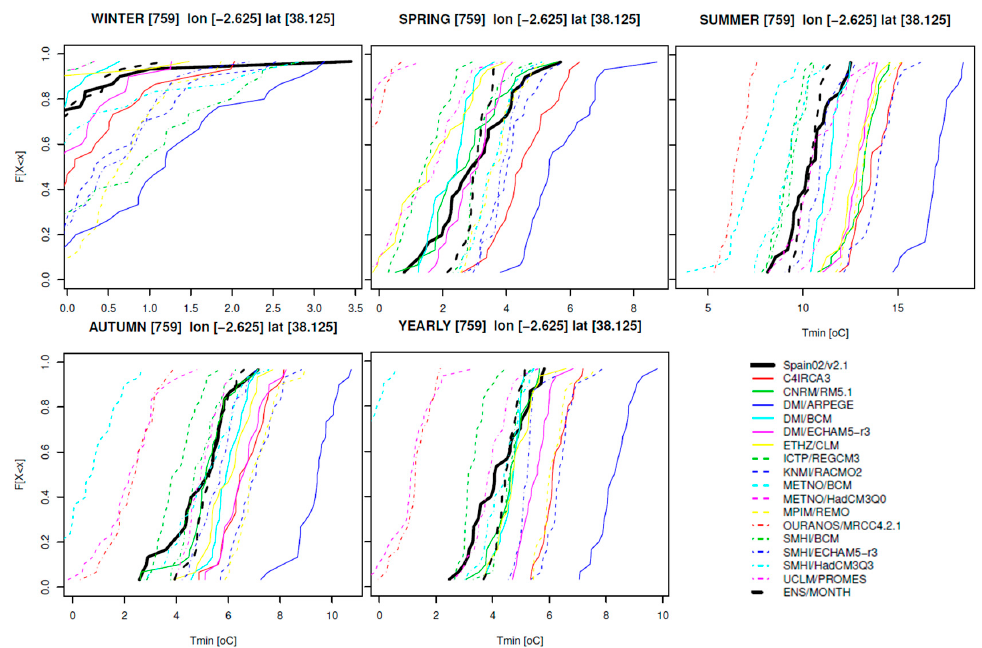
Figure 7. Seasonal and yearly minimum temperature CDFs on site 759, located in the Fuensanta Basin, from observational dataset (in black), RCMs (in color) and RCM ensembles (black dashed black), for the 1961–1990 period.